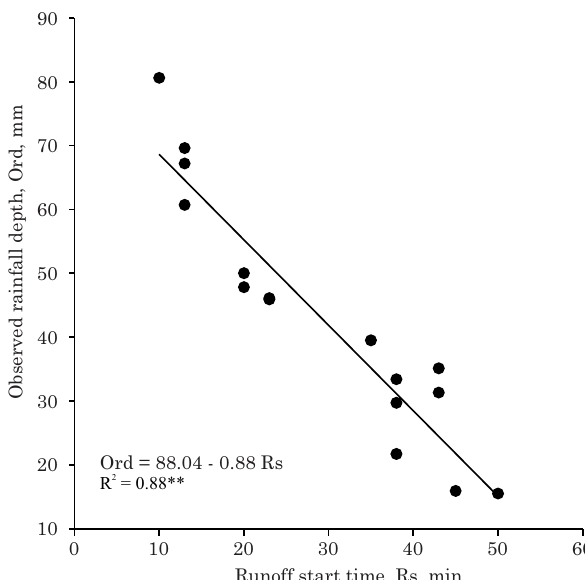
Figure 2. Relation between the observed runoff depth, Ord, and the runoff start time, Rs, under four treatments and rainfall tests, on a Humic Dystrudept soil.